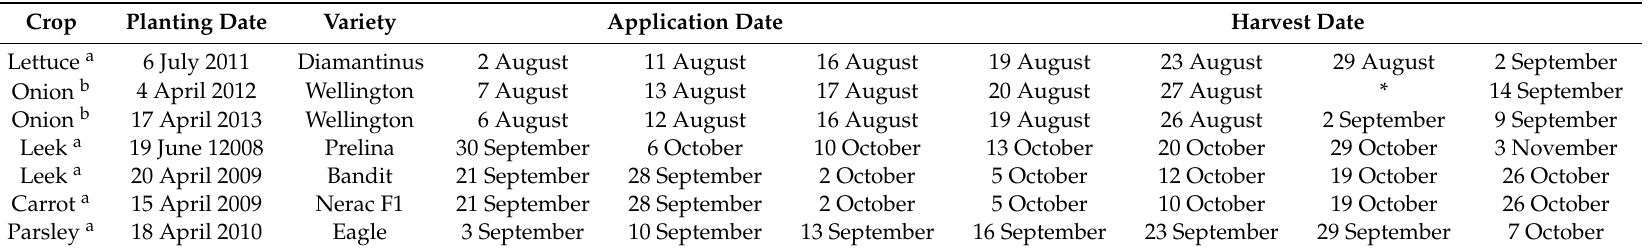
Table 1. Crops, planting dates, varieties, as well as the dates of pesticide application and crop harvest in semi-field